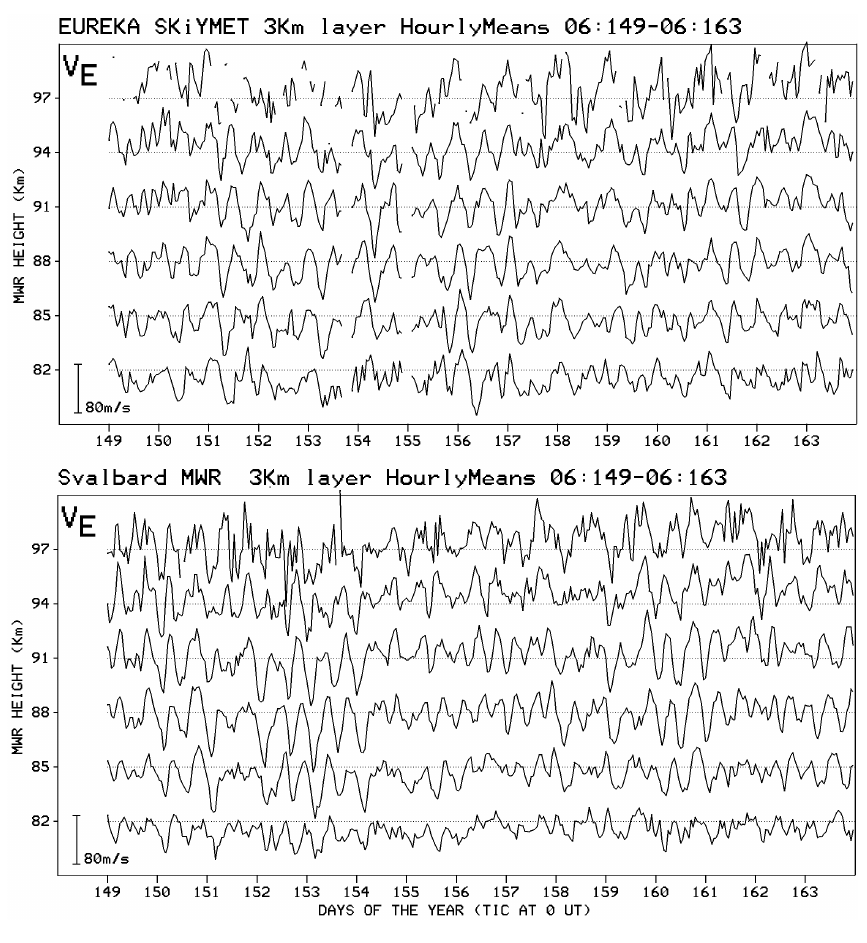
Fig. 2. Time sequences of the Zonal, or East-West